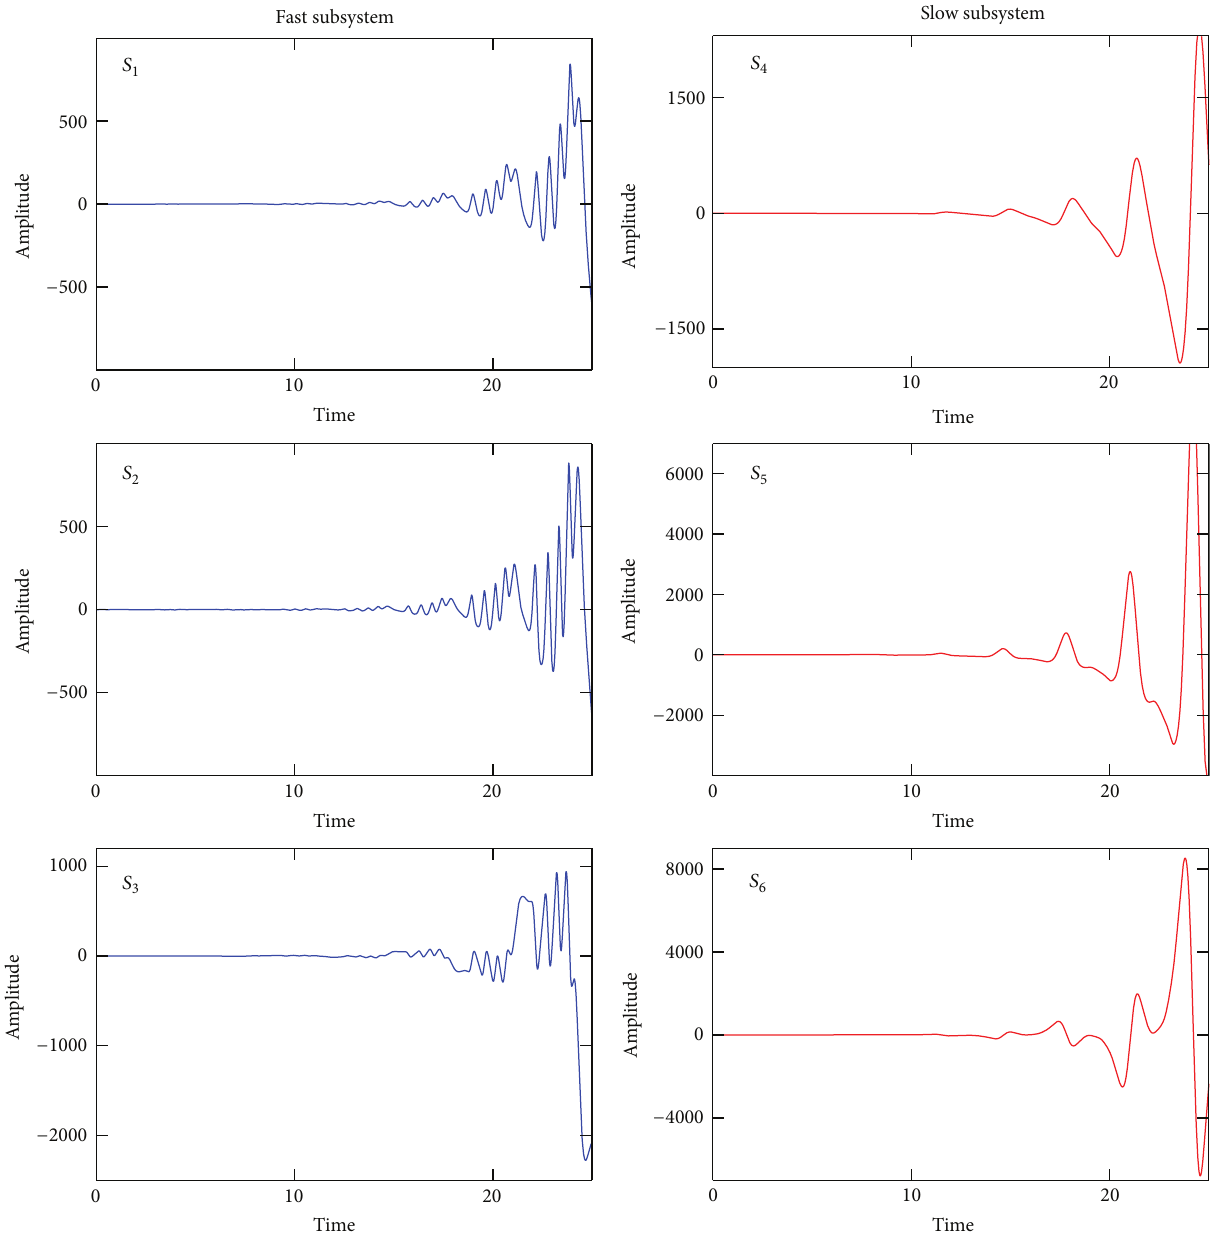
continuous dynamical systems close points of